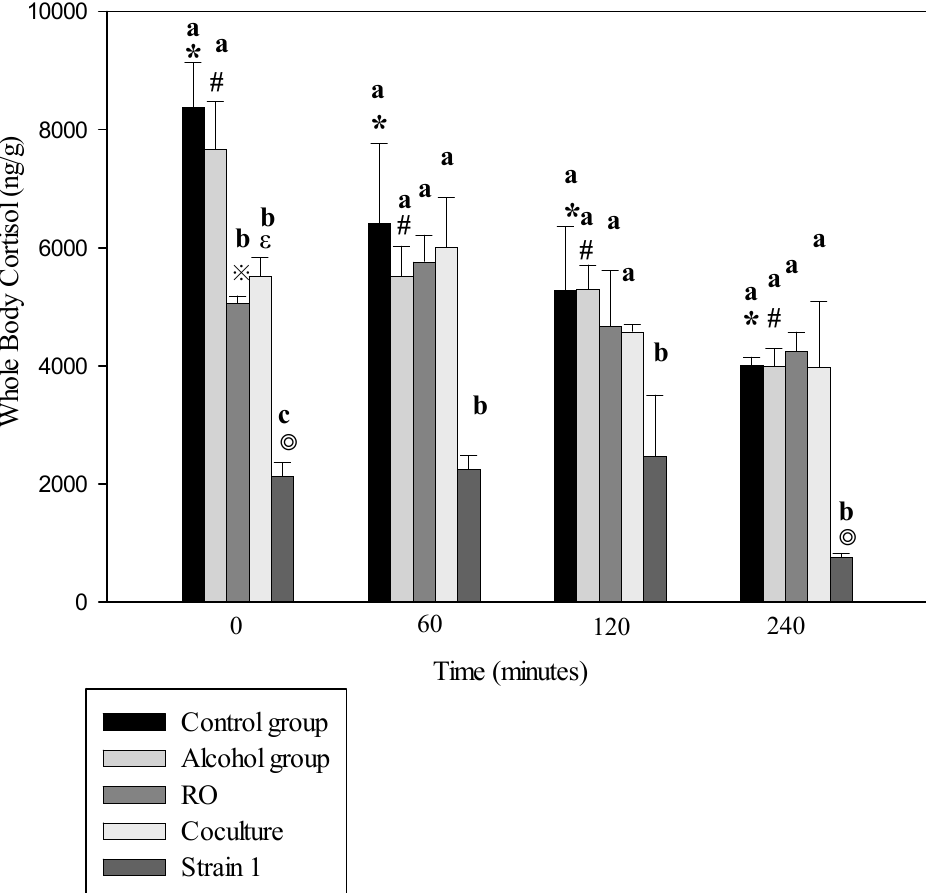
Figure 3. Kinetics of whole-body cortisol secretion in zebrafish subjected to treatment with tempeh ferments. The vertical axis represents the whole-body cortisol secretion of the zebrafish (ng/g). Bars show means of triplicates ± SD. *, #, ※ , ε , and ◎ represent p < 0.05 as compared with the 0-min group cortisol level (ng g − 1 ). a – c: the same bar with different letters are significantly different, p < 0.05.